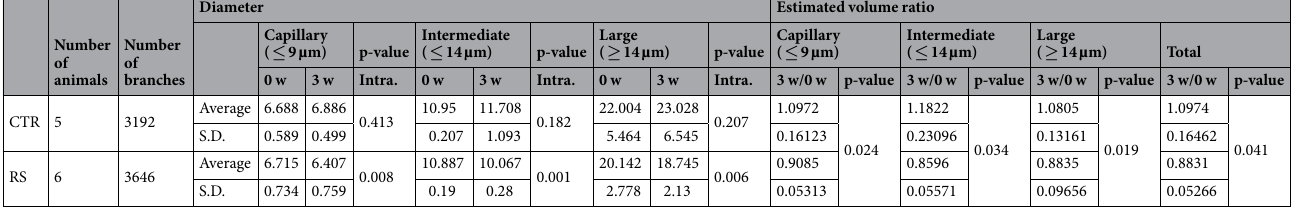
Table 1. Estimated diameter and reconstructed volume of selected blood vessels.